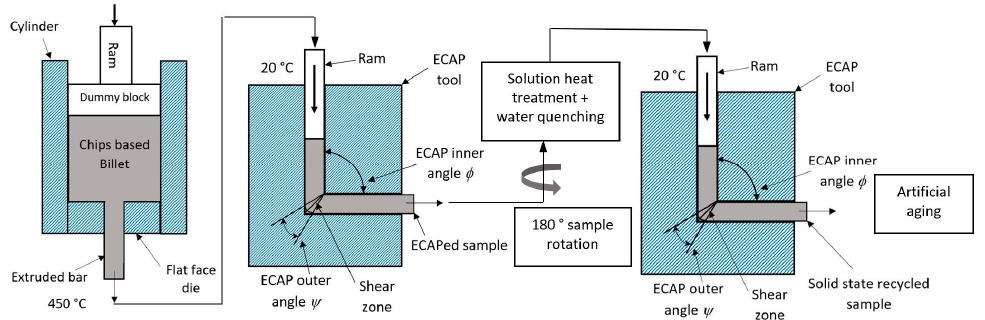
Figure 2. Schematic representation of the solid state recycling process (direct hot extrusion (DE) + equal channel angular pressing (ECAP) + heat treatment).